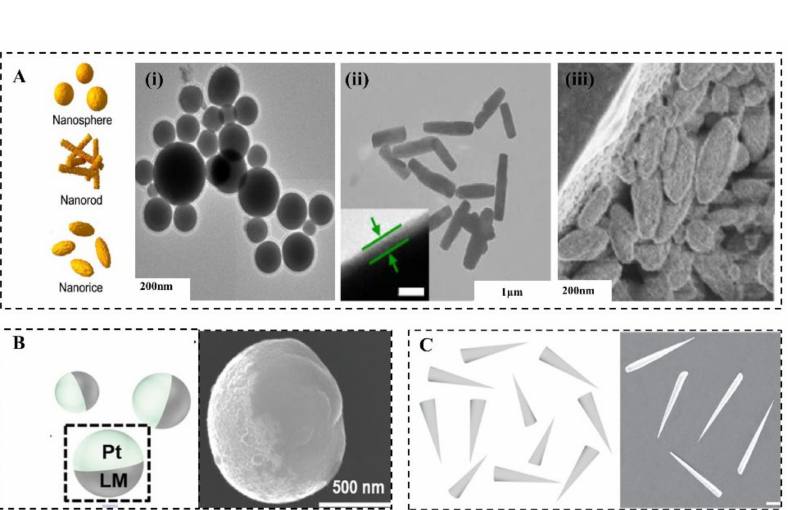
Figure 2. Shapes of LM micro/nanomaterials (LMMMs) and motors. ( A ) Different shapes of LM nanomaterials. ( i ) Transmission electron microscopy (TEM) of eutectic gallium indium liquid alloy micro-and nanoparticles [45]. ( ii ) TEM of EGaIn alloy rods [25]. ( iii ) SEM image of EGaIn nanorices [47]. The asymmetric shape of MCLMTs: ( B ) Janus sphere [6] and ( C ) needle